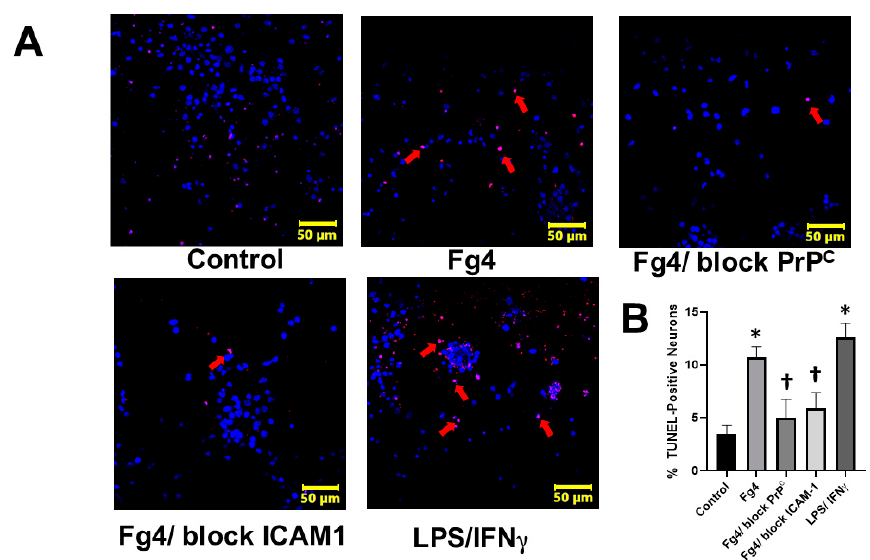
Figure 5. Fibrinogen (Fg)-induced astrocyte activation causes apoptosis of co-cultured neurons ( A ) Representative images of neuronal apoptosis assessed by Terminal deoxynucleotidyl transferase- dUTP nick end labeling (TUNEL) assay. TUNEL assay is a method for detecting DNA fragmentation by labeling the 3 ′ - hydroxyl termini in the double-strand DNA breaks generated during apoptosis. Neurons were co-cultured with astrocytes treated with Fg for 24 h. Astrocytes were treated with medium alone (control), 4 mg/mL of Fg (Fg4), 4 mg/mL of Fg in the presence of a function-blocking peptide against cellular prion protein (Fg4/block PrP C ) and 4 mg of Fg in the presence of function- blocking antibody against intercellular adhesion molecule-1 (Fg4/block ICAM-1). For positive control, lipopolysaccharide (LPS) was used at 1 µ g/mL with co-stimulation with 20 ng of a murine interferon gamma (IFN γ ). Immunostaining of apoptotic (red) neurons with 4 ′ ,6-diamidino-2-phenylindole (DAPI, blue) nuclear stain is shown. Arrows indicate some of the apoptotic cells (red). ( B ) Summary of image analyses for the detection of apoptotic neurons presented as a percent of a total number of cells. p < 0.05 in all; ∗ - vs. Control, † - vs. Fg4; n = 4.